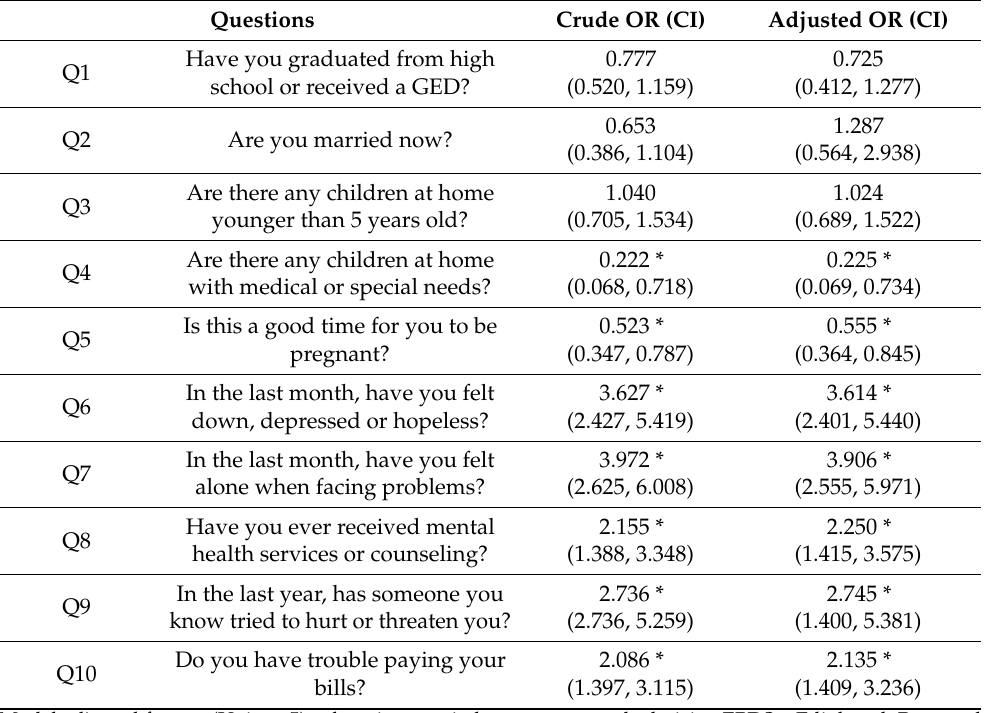
Table 2. Crude and Adjusted Analysis of the Association between Healthy Start Screening Questions and Positive EPDS